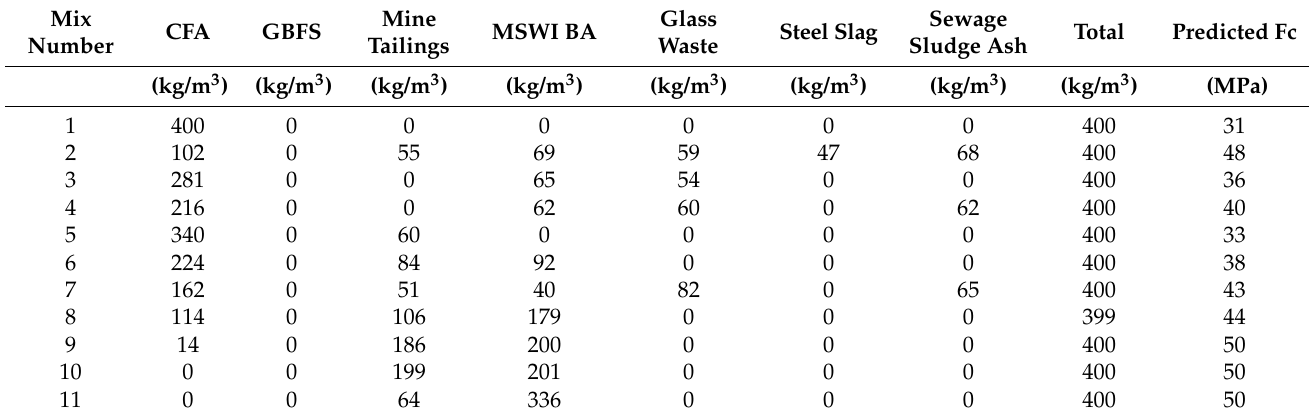
Table 2. Selected optimal mixes in Finland.